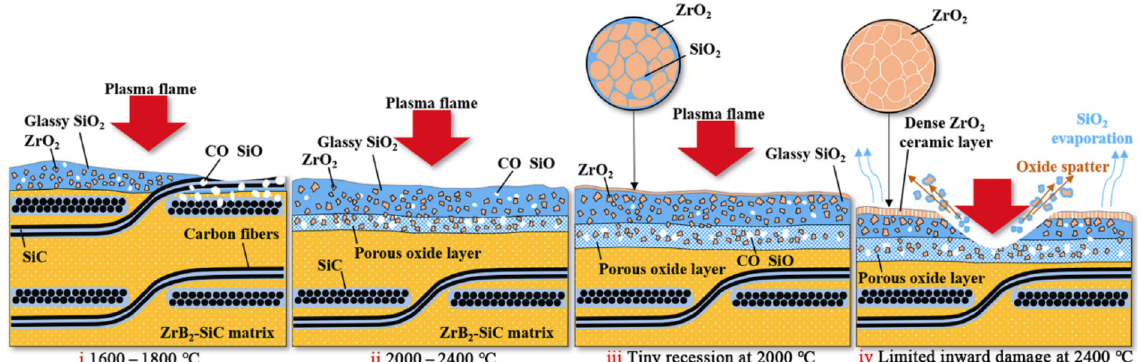
Fig. 27 Schematic diagram of the ablation mechanisms for 2D-C f /ZrB 2 –SiC composites at temperatures from 1600 to 2400 . ℃ Reproduced with permission from Ref. [198], © Elsevier Ltd.